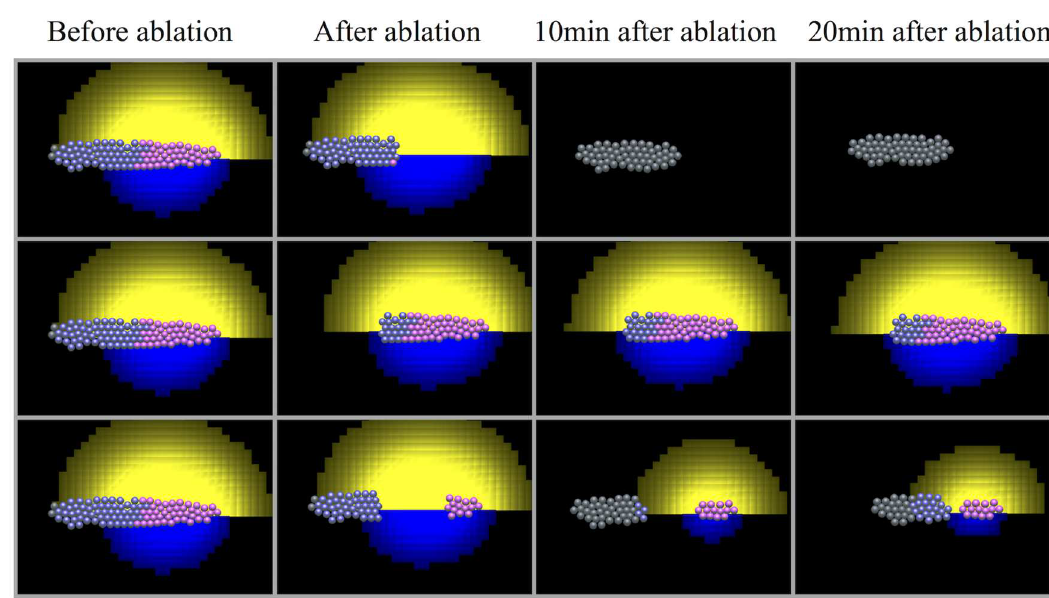
Fig 11. Recovery after partial ablation. As in laser ablation from [8], part of the PLLP is removedin the simulation, and recovery observed. Top row: the front segment (WntR active cells) is removed, leavingonly FGFR active cells; the PLLP stalls and cannot continue.Middle row: the rear portion is removed, leavinga few FGFR cells behind; the PLLP migration continues.Bottom row: the middle segmentis removed. Motion is stalled whilethe trailingFGFR active cluster catches up with the front. Once the clusters have merged,